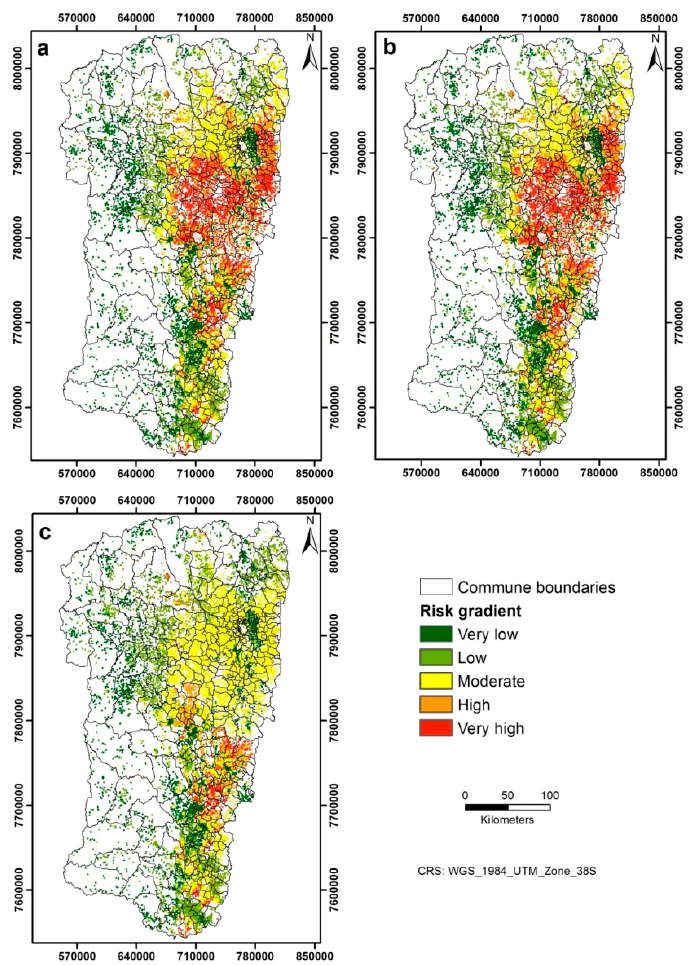
Figure 3. Suitability maps for Malaria. ( a ) 2014; ( b ) 2015; and ( c ) 2016.